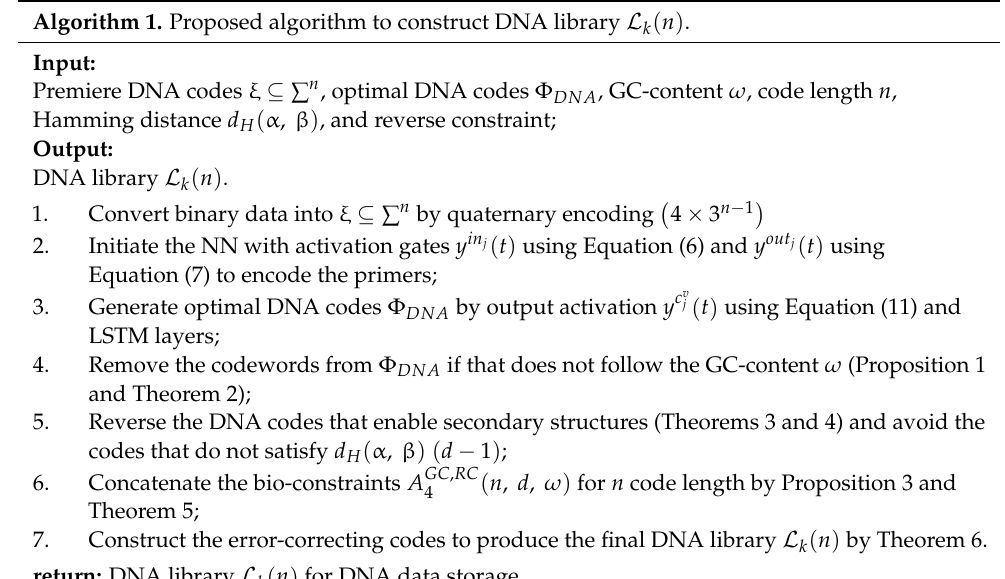
Table 1. Comparison of our lower bounds with [10] for 𝐴 (cid:2872)(cid:3008)(cid:3004) (cid:4666)𝑛, 𝑑, 𝜔(cid:4667) .